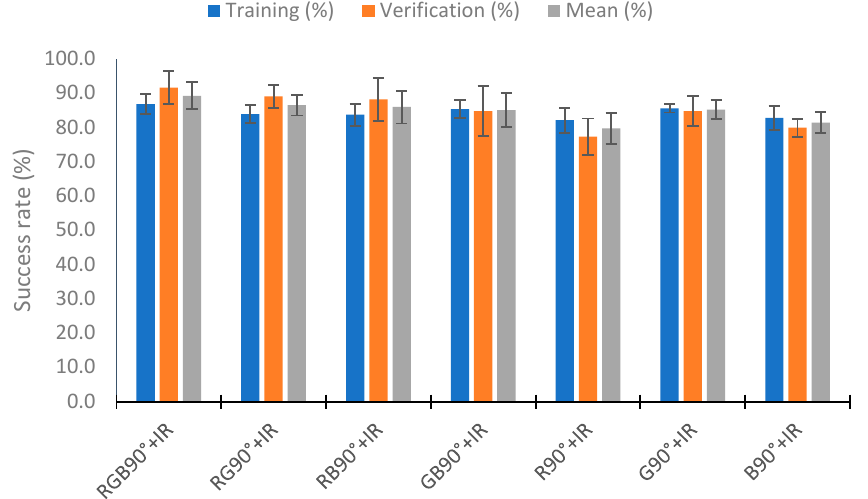
Figure 21. Success rate in the neural network with the data at 90° of the RGB light and IR light. Figure 22 represents the results obtained by eliminating visible wavelengths in the combination of the IR90° light. Except for the con fi guration of R + IR90°, with success rates of 85.6% in the veri fi cation and 81.7% in the veri fi cation (a mean of 83.7%), the results are similar. The maximum improvement in the mean is 2% in the con fi guration GB + IR90°.